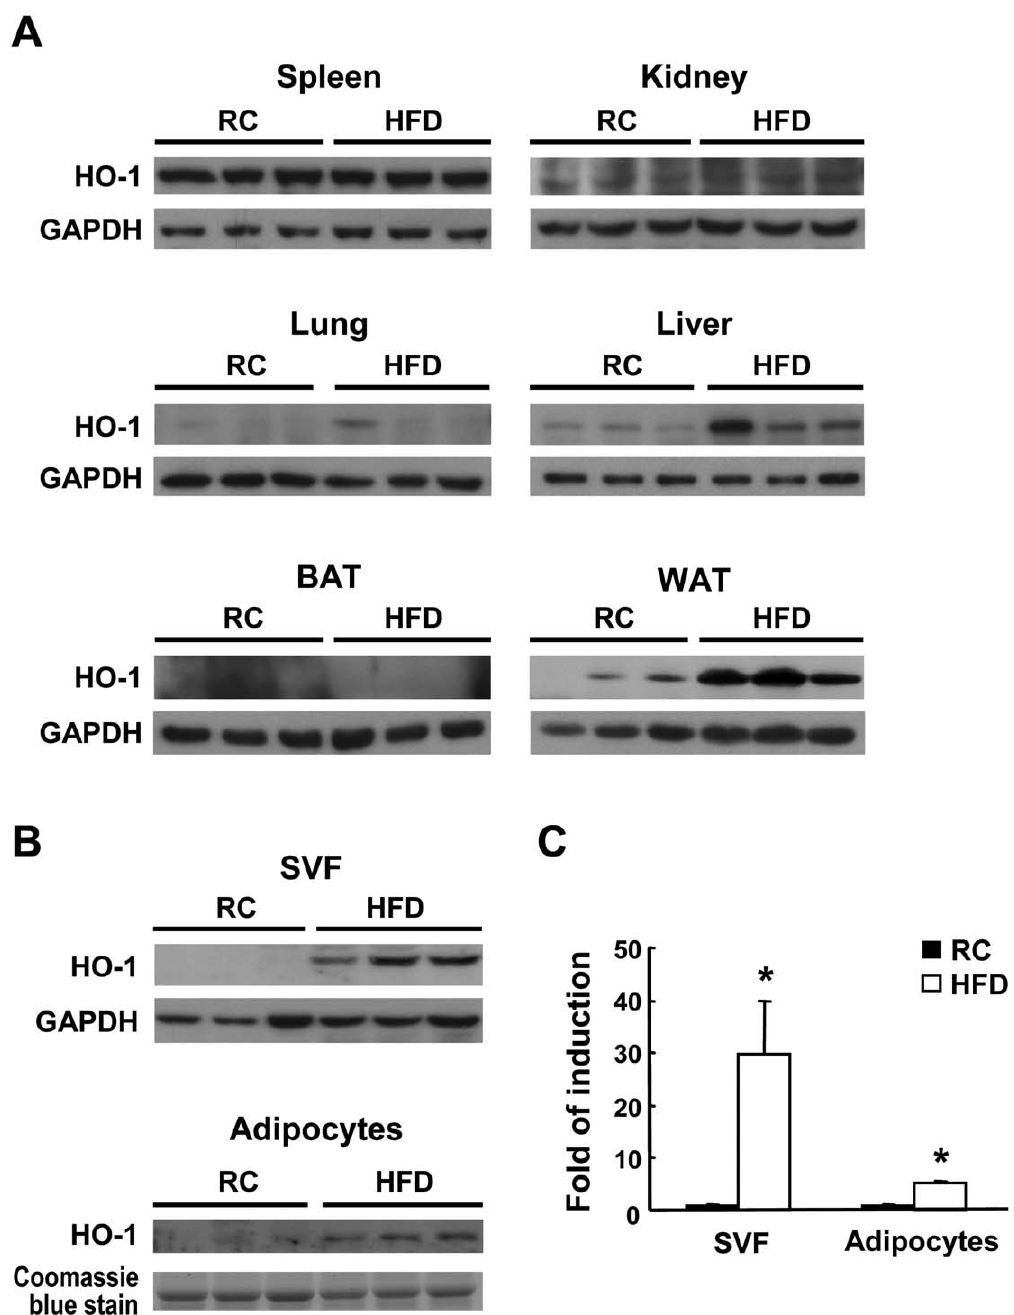
Figure 1. Effect of HFD feeding on HO-1 expression in various tissues. Male B6 mice (8-week-old) were fed a regular chow (RC) diet or a HFD for 12 weeks, then were sacrificed. A, HO-1 protein expression in the spleen, kidney, lung, liver, brown fat tissue (BAT), and white fat tissue (WAT) of three mice per group examined by Western blot analysis. B, The SVF and adipocytes from the visceral fat tissue were isolated from three individual mice of each group and subjected to Western blot analysis. C, HO-1 levels were quantified by densitometry. * P , 0.05 vs the chow diet-fed group. doi:10.1371/journal.pone.0038626.g001 of the adipocytes, but no significant difference between the WT (Fig. 3C & 3D). We also performed immunostaining with and HO-1 + / 2 chimeras (Fig. S3A). Immunostaining experiments antibody against CD31, a specific marker of endothelial cells. As performed with antibody against the macrophage surface marker, shown in Fig. 3E & 3F, the vascular density, after normalization F4/80, showed that the extent of macrophage infiltration, by the adipocyte density (Fig. S3B & S3C), in the adipose tissue characterized by a crown-like structure surrounding dead was significantly increased in HFD-fed chimeras and was much adipocytes, was significantly higher in the WAT of the HFD- higher in the HFD-fed WT chimeras than in the HFD-fed HO- fed WT chimeras than in the corresponding HO-1 + / 2 chimeras 1 + / 2 chimeras. To assess the effect of the infiltrating WT and